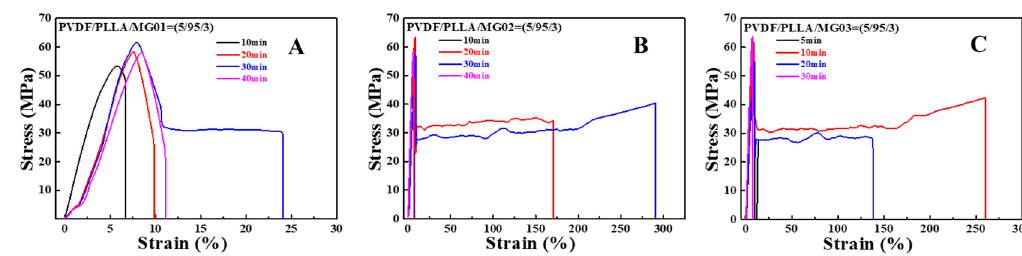
Figure 2. Stress–strain curves of the PVDF / PLLA blends with various compatibilizers and mixing time: MG01 ( A ), MG02 ( B ), MG03 ( C ). Table 1. Mechanical properties of the PVDF / PLLA blends with various compatibilizers and mixing time. Mixing Sample